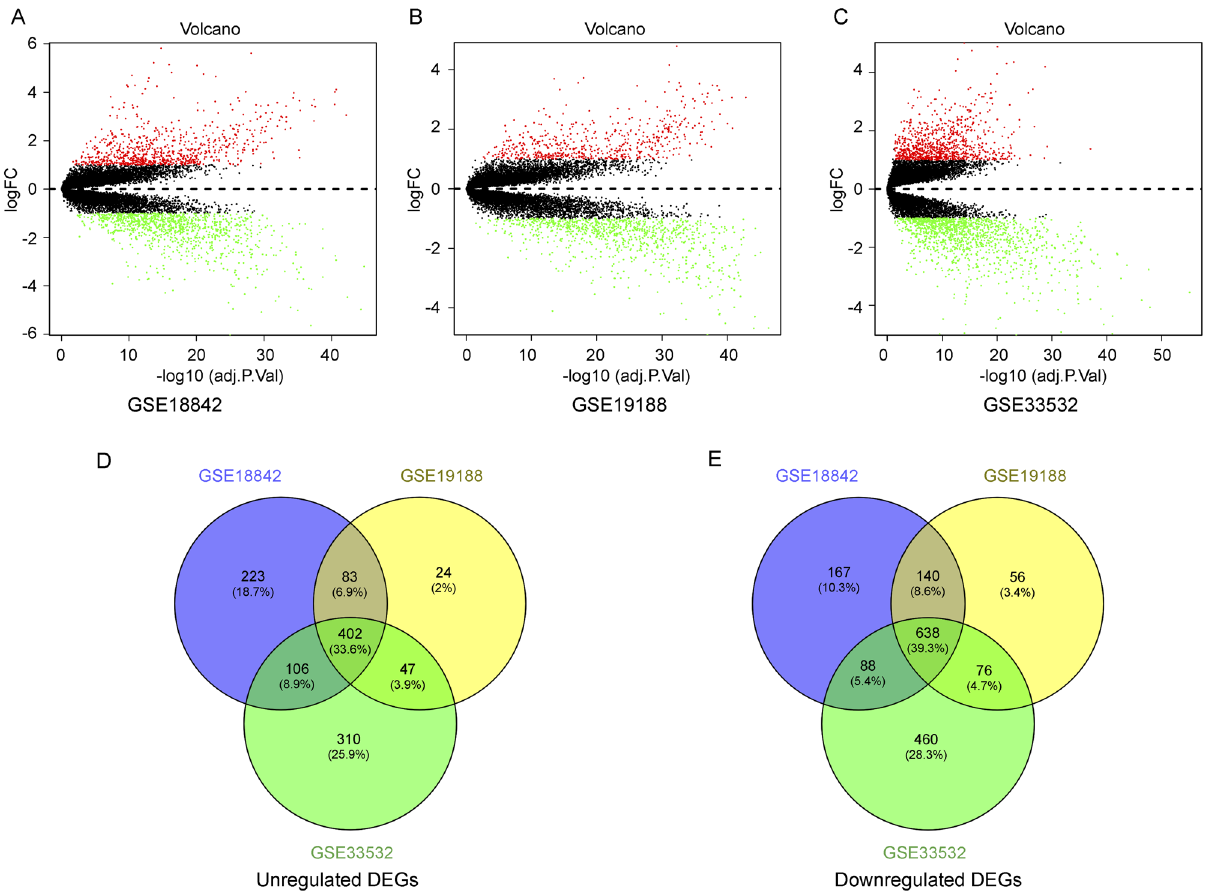
Figure 1. Identification of differentially expressed mRNAs between lung adenocarcinoma (LUAD) and normal samples in three Gene Expression Omnibus (GEO) datasets. ( A – C ) Volcano plots of DE-mRNAs in GSE18842, GSE19188, and GSE33532. Horizontal axis represents the − log 10 (adjusted p-value) and vertical axis represents the log 2 (fold change) of gene expression. Green dots and red dots represent significantly downregulated and upregulated genes, respectively. Black dots represent genes with no significant difference. ( D , E ) The intersection of upregulated and downregulated genes in three datasets, respectively. DEG; DE-mRNA: Differentially expressed